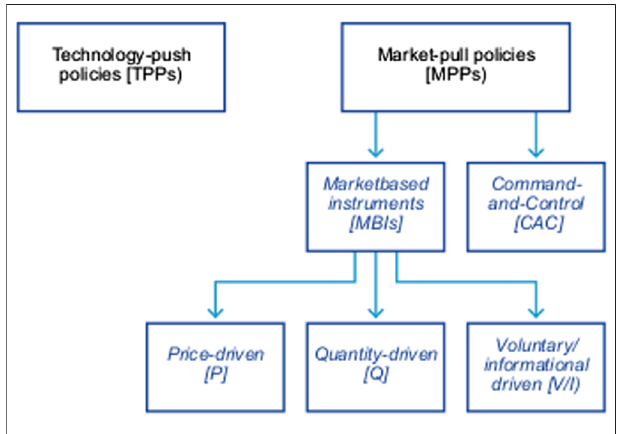
FIGURE 2 | Classi fi cation of policies (e.g., Ecorys, 2011; Groba and Breitschopf, 2013; Hendriks et al.,